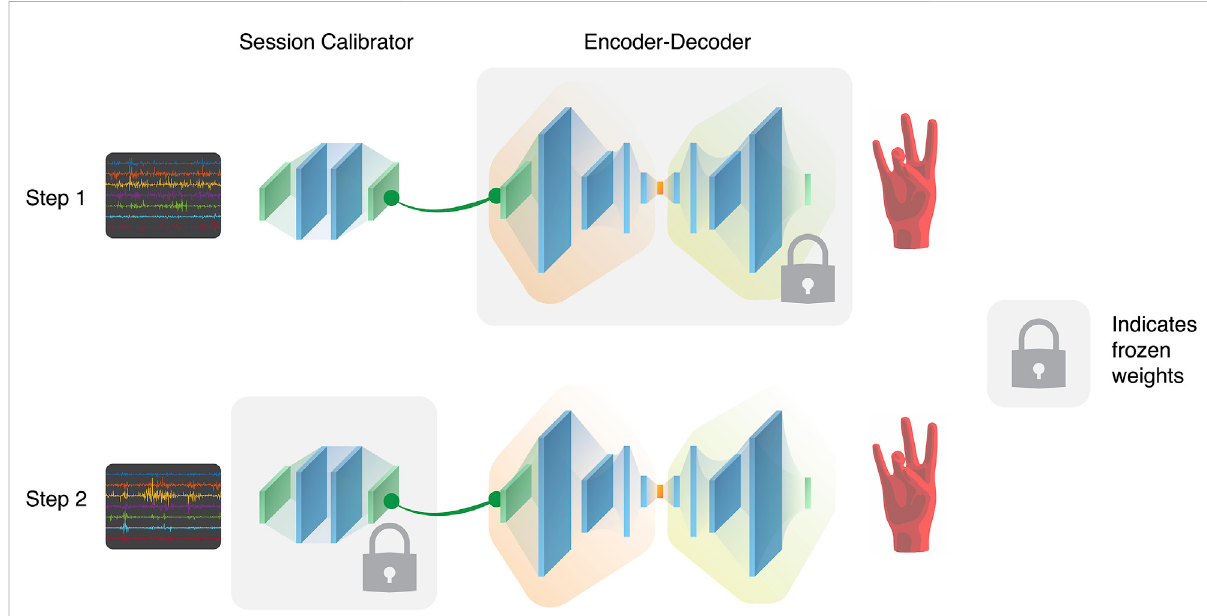
FIGURE 7 Theproposedsession-speci fi ccalibrationscheme,whichhastwostagesinbothtrainingandevaluation.Wheneveranewsessionisintroduced, anewsession-calibratorarchitectureiscreatedandtrainedwhilefreezingtheencoder-decoderarchitecture.Oncethesession-calibratoristrained, itisfrozen,andtransformstheinputsintoamoresession-independentformattobeusedasinputstotheencoder-decoder.Thesession-calibratoris frozen and the encoder-decoder is trained on the current session, with less session-speci fi c